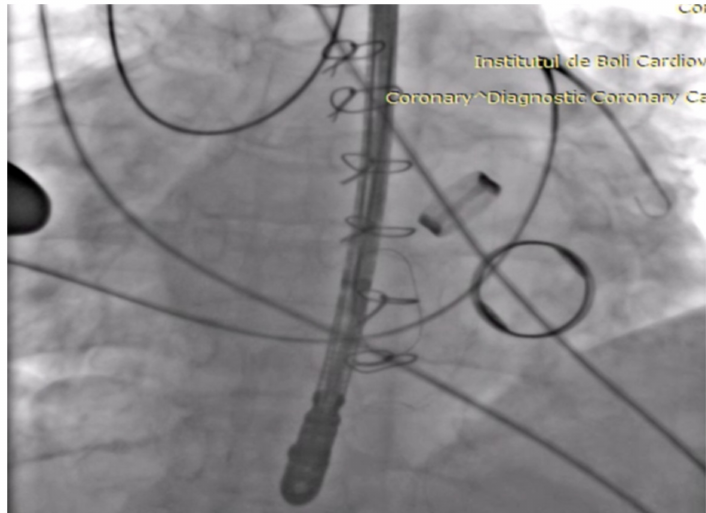
Figure 3. Fluoroscopic image showing the mechanical mitral and aortic prostheses, the tricuspid bioprosthesis, prior pacing leads and the sti ff wire.